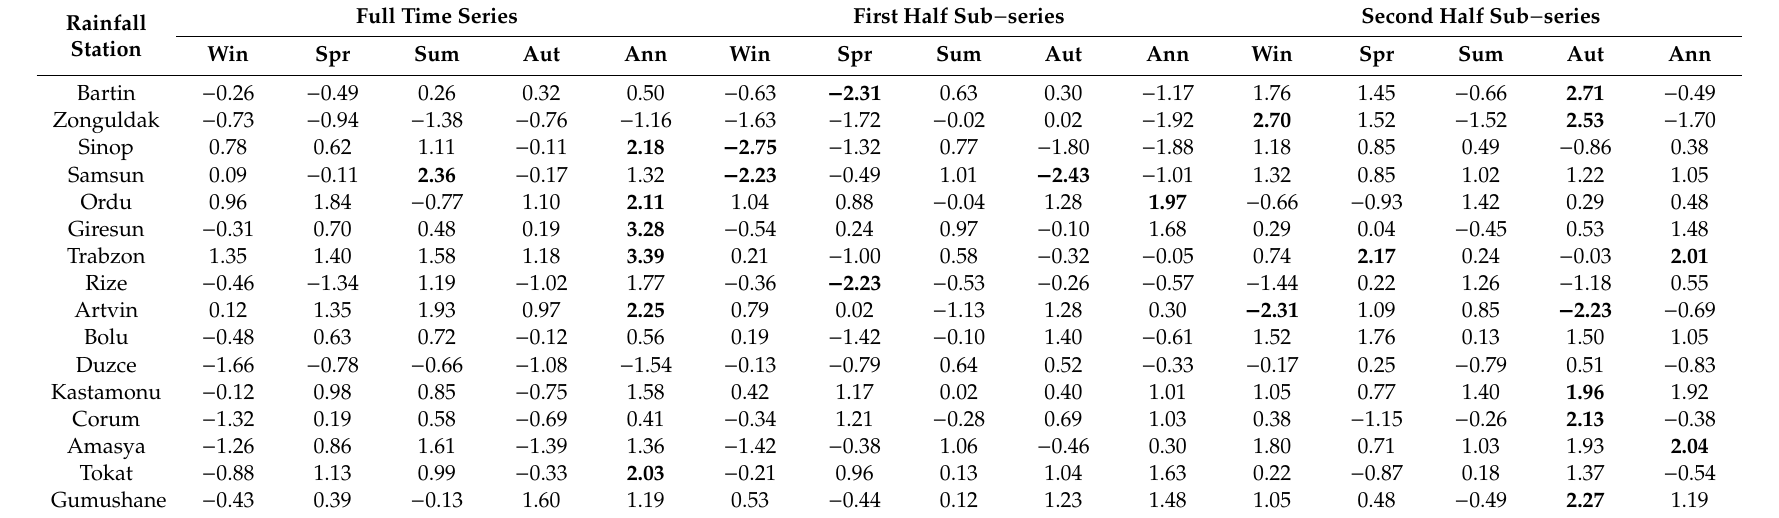
Table 4. Statistical results ( Z MK ) of trend analysis for annual rainfall using the MK